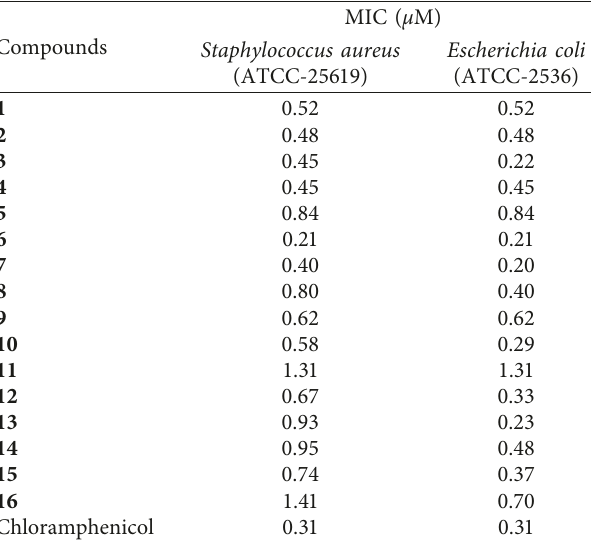
in µ M) of the compounds 1 – 16